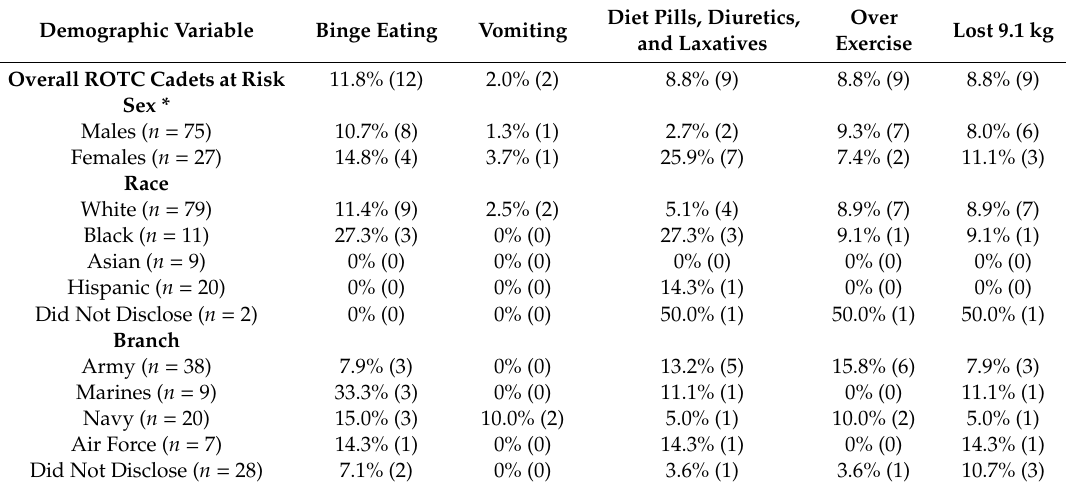
Table 4. Proportion of ROTC cadets classified as at risk for specific pathogenic behaviors (percent and sample size).